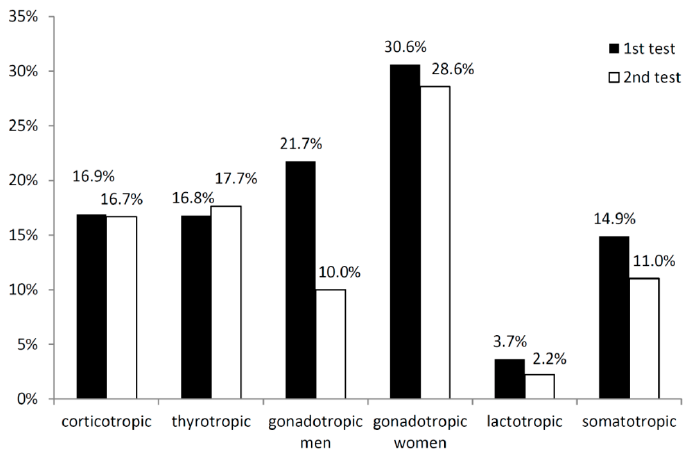
Figure 2. Pituitary insufficiencies defined by lowered basal laboratory values or receiving hormone replacement in the first hormonal assessment after a median of three months (first test) and the follow-up after a median of seven months (second test) in patients after traumatic brain injury (TBI) and subarachnoid hemorrhage (SAH).